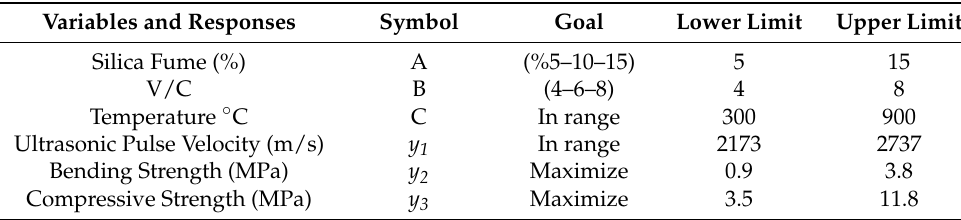
Table 7. Multi-objective optimization criteria.